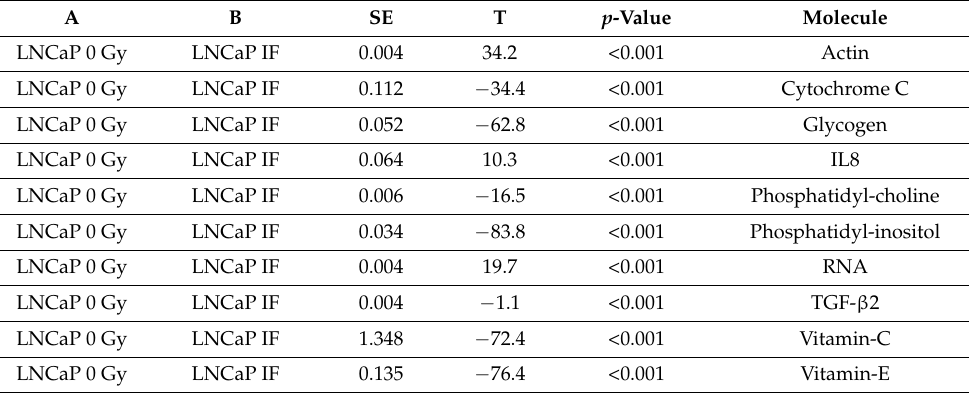
Table 4. Results of post hoc pairwise testing with the Games-Howell approach on CLS coefficients from fitting of LNCaP cell spectra. Column A and B of the table identify the paired classes which are compared for each molecule, with SE denoting the standard error on the mean and T the